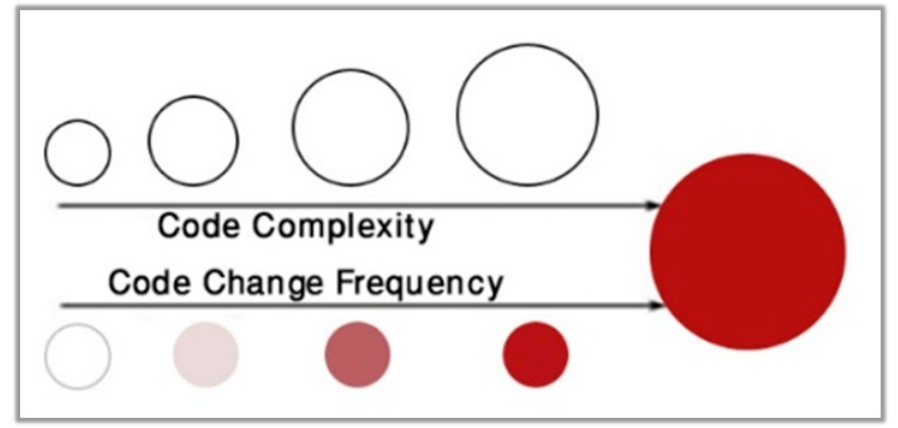
Figure 1. Hotspot calculation of the code.